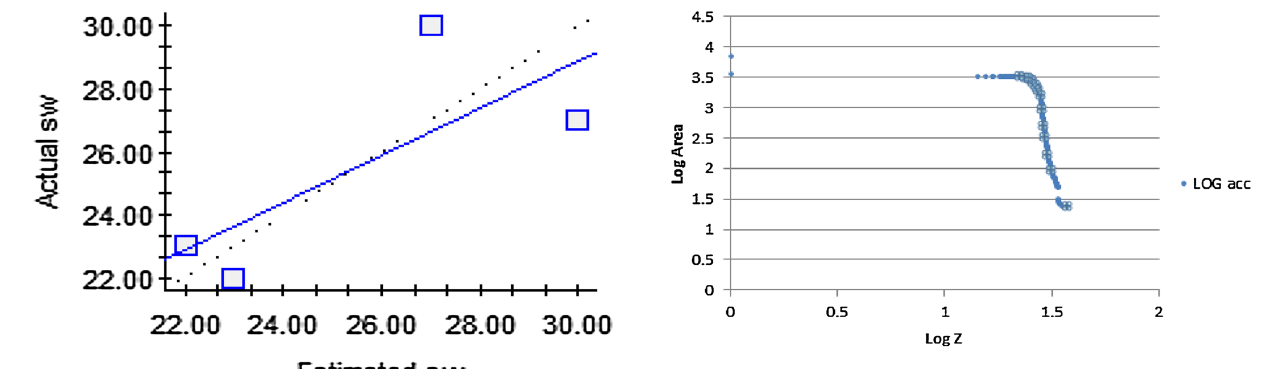
Fig. 7 Validation of water saturation estimation by the Kriging method